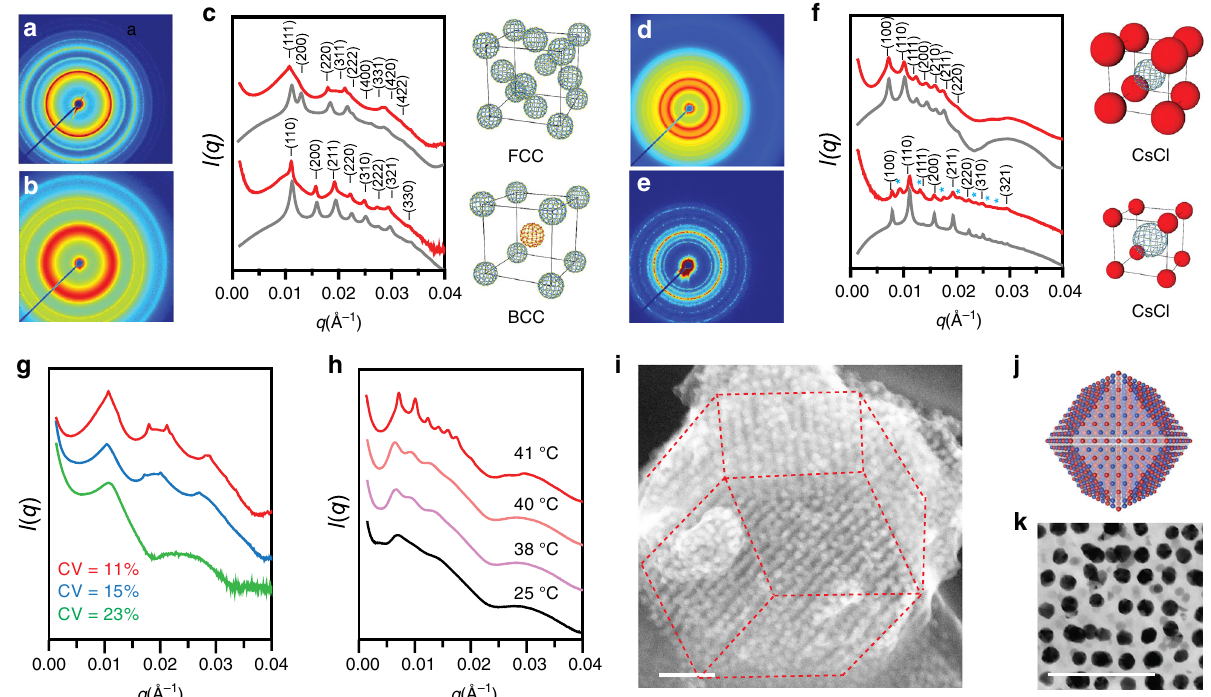
Fig. 3 Colloidal crystal engineering with MOF PAEs. a – c 2D SAXS and radially averaged 1D SAXS patterns (in logarithmic scale) for superlattices formed from a 37 nm UiO-66 NPs in an fcc arrangement assembled with self-complementary DNA and b binary 37 nm UiO-66 NPs in a bcc arrangement assembled with complementary DNA. Experimental data are shown in red, and simulated scattering patterns are shown in gray. d – f 2D SAXS and radially averaged 1D SAXS patterns (in logarithmic scale) for CsCl lattices formed from complementary DNA functionalized d 37 nm UiO-66 NPs and 20 nm AuNPs (1:1 ratio) and e 37 nm UiO-66 NPs and 40 nm AuNPs (1:1 ratio). AB 2 impurity phase is indicated by blue asterisks. g SAXS data of UiO-66 NPs of different uniformity prepared by sucrose-gradient ultracentrifugation: red, 34 ± 4 nm (CV = 11%); blue, 39 ± 6 nm (CV = 15%); green, 47 ± 11 nm (CV = 23%). h In situ SAXS monitoring the thermally induced transition of MOF – Au PAE aggregates from the amorphous to crystalline state. i Secondary electron STEM image of a single crystalline UiO-66 NP and 40 nm AuNP hybrid superlattices with j rhombic dodecahedra crystal habits, and transmission electron image of k an 80-nm-thick sample cross-section prepared by ultramicrotomy. All scale bars are 200